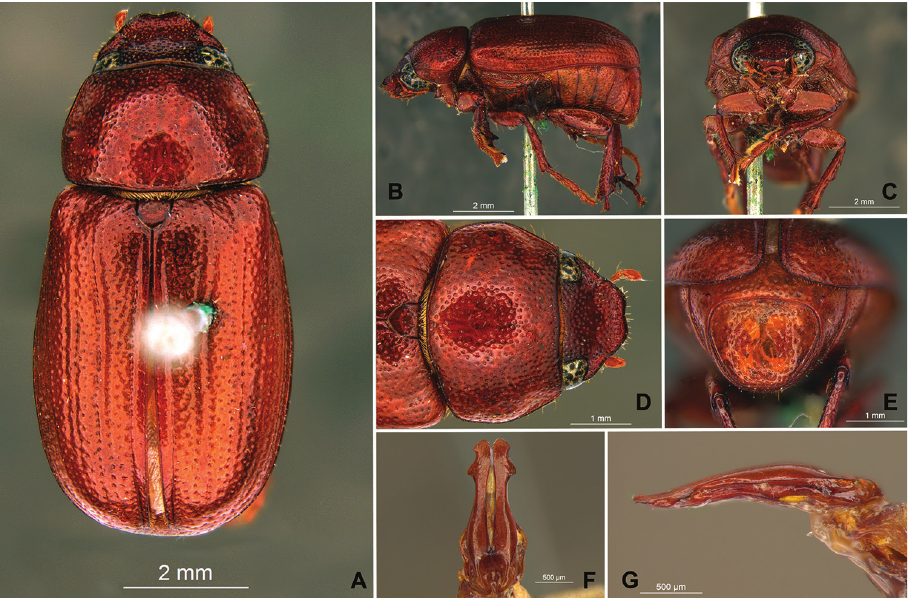
Figure 70. Liogenys rufocastanea Moser. A Dorsal view B Lateral view C Frontal view D Clypeus and pronotum E Pygidium F Parameres, dorsal view G Parameres, lateral